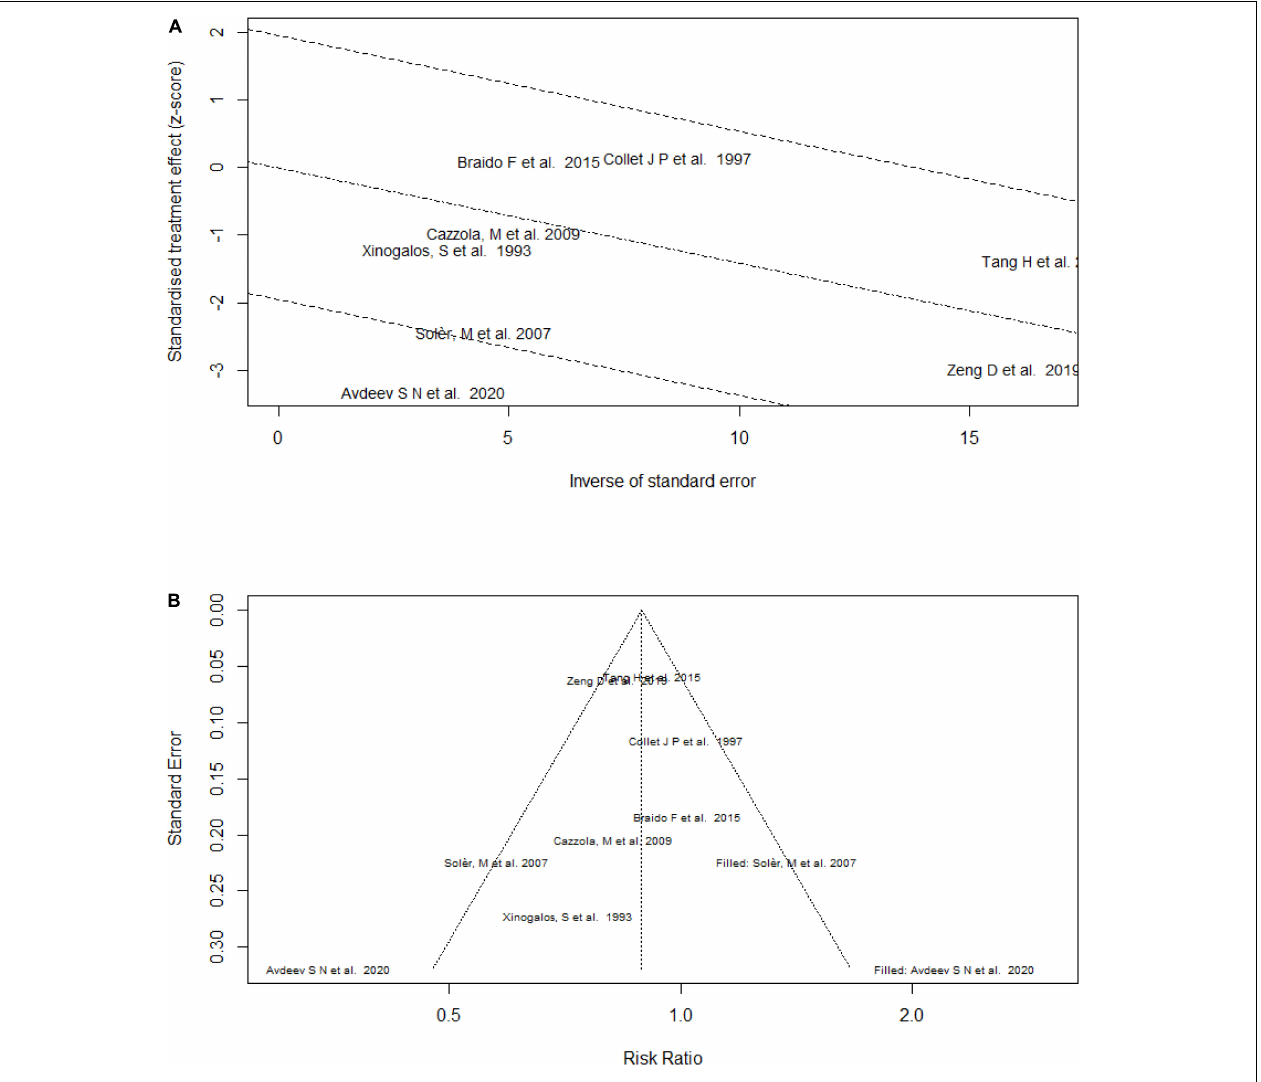
FIGURE 7 | Radial plot and funnel plot of the efficacy of bacterial lysates on the rate of exacerbation. (A) Radial plot of the efficacy of bacterial lysates on the rate of exacerbation. (B) Funnel plot of the efficacy of bacterial lysates on the rate of